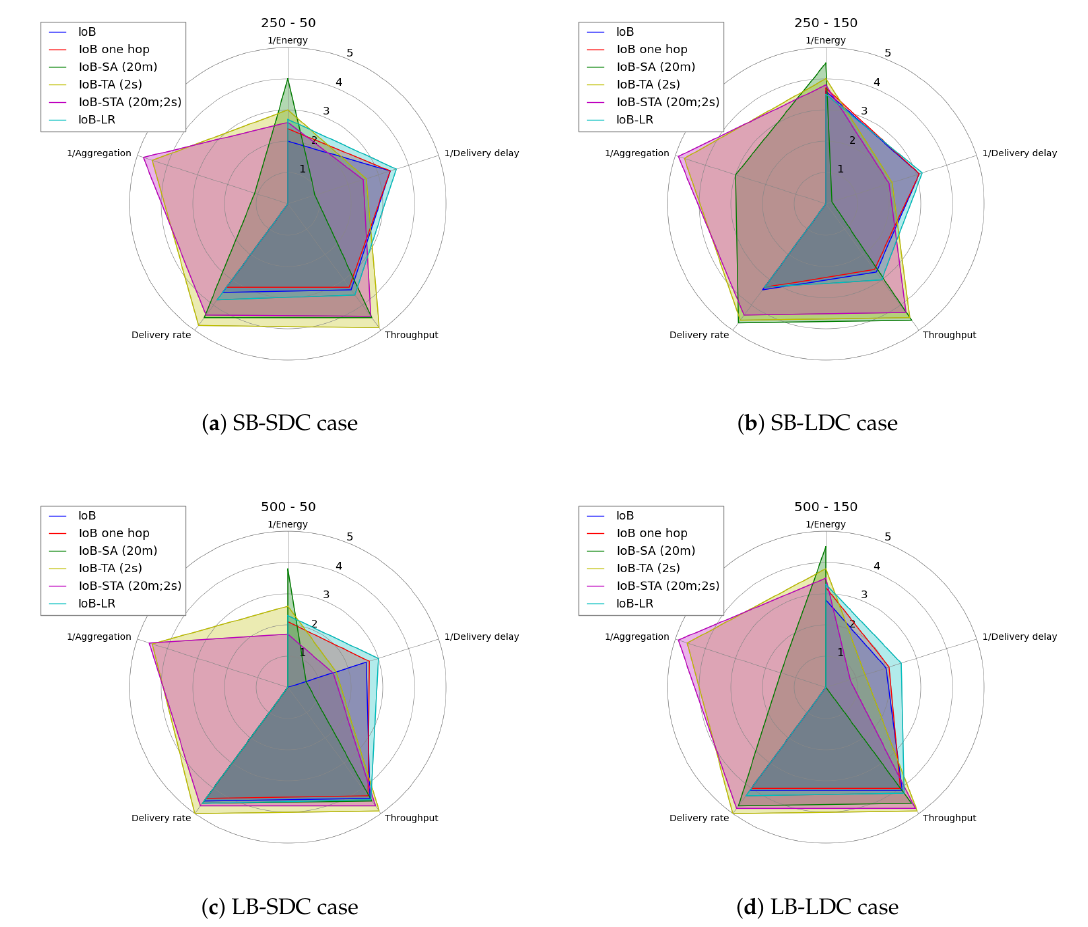
Figure 46. Performance comparison of IoB protocol variants.